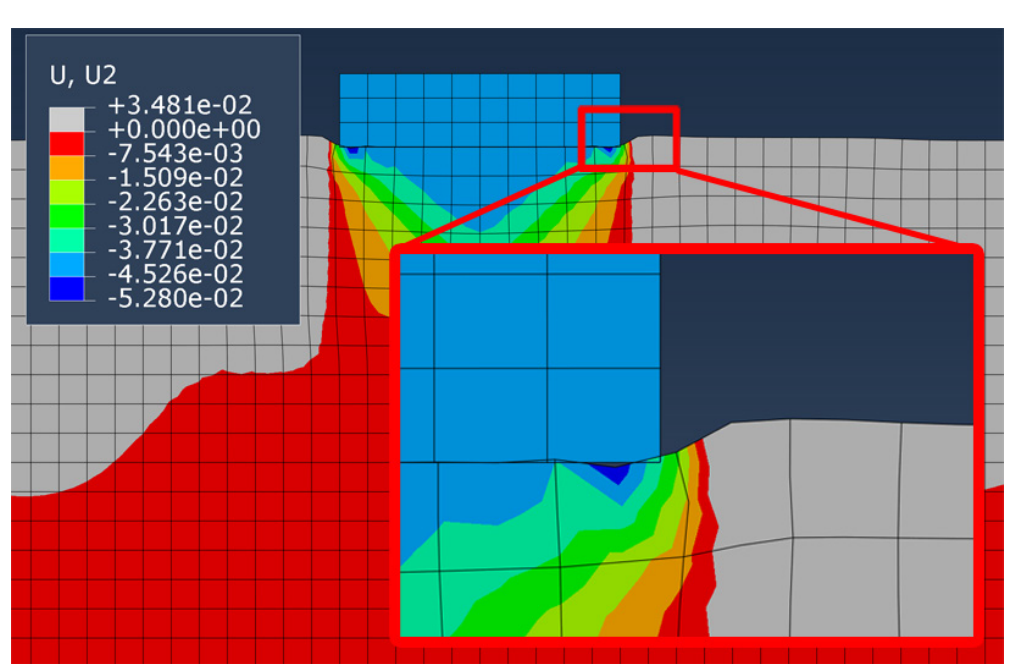
Figure 3: Distribution of vertical displacement in elements adjacent to the strip